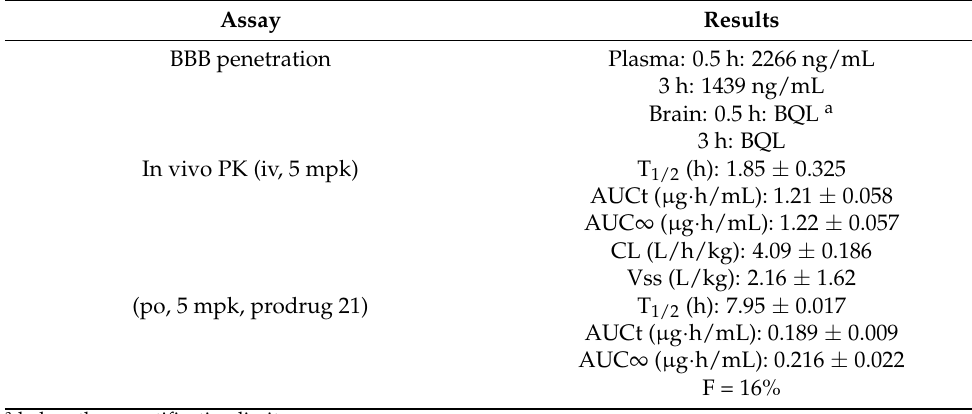
Table 6. BBB ratio and pharmacokinetic parameters of 18i in male